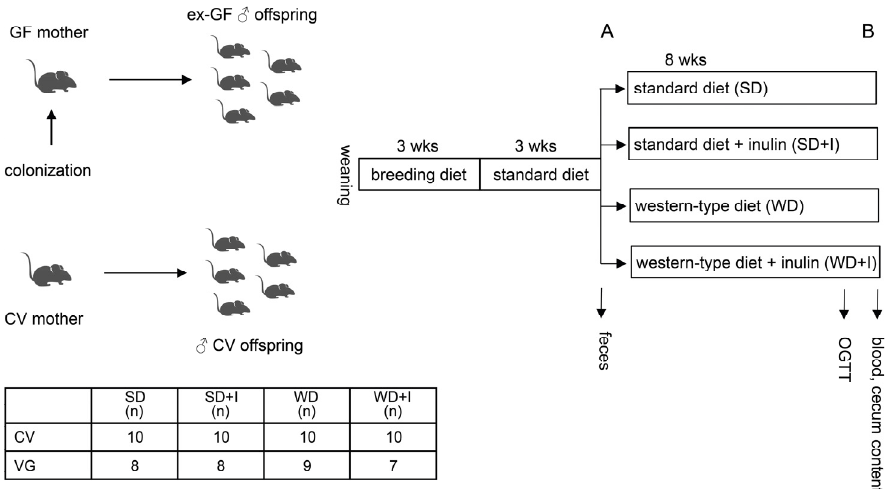
Figure 1. Experimental design . CV, conventional mice; GF, germ-free; OGTT, oral glucose